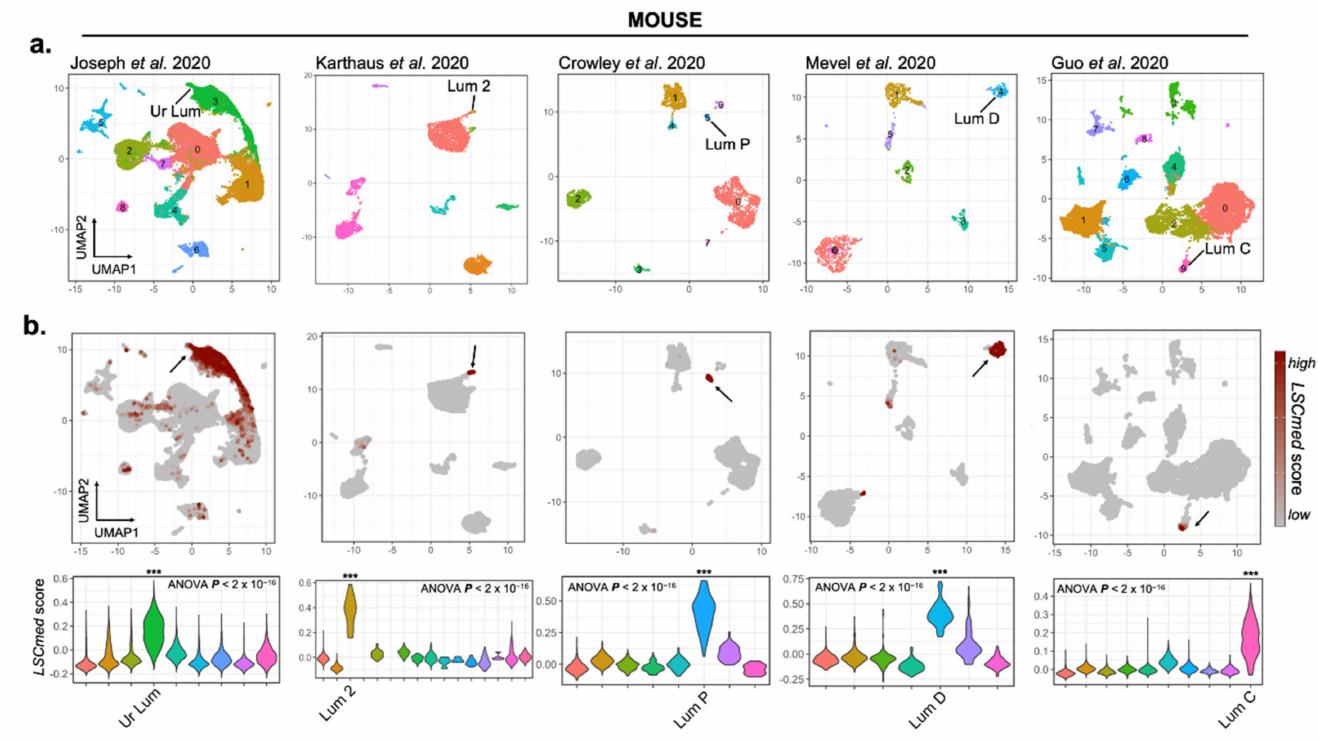
Figure 1. Transcriptomic similarity between FACS-enriched WT mouse LSC med cells and luminal pro- genitor cell clusters identified by scRNA-seq analyses of WT mouse prostates. ( a ) UMAP projections based on linear dimensionality reduction by principal component analysis (PCA) for, from left to right, 45,432 [17], 5158 [15], 2362 [16], 1213 [14] and 19,503 [10] single-cell transcriptomes. ( b ) In each study, a single subpopulation matched LSC med -like cells [5], as shown by high calculated LSC med gene signature scores (see LSC med score calculation in Methods). The violin plots show the calculated LSC med scores per cluster and per study (***, Tukey’s multiple comparisons of means P adj < 0.001 for all pairwise comparisons